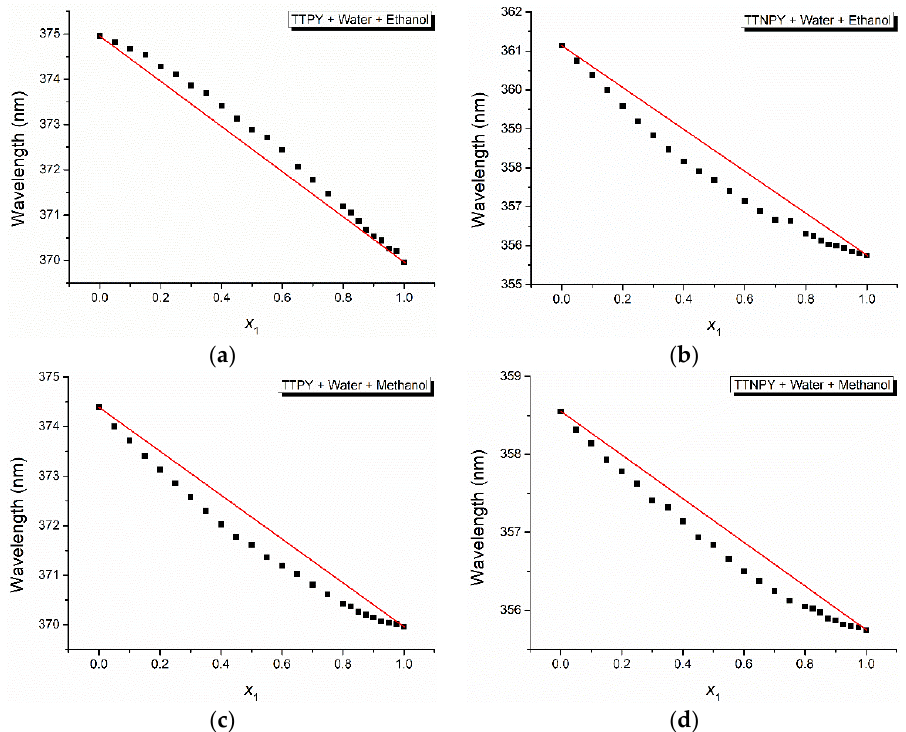
Figure 8. Wavelength in the maximum of the electronic absorption bands versus the water content for the investigated binary solvent mixture solutions of 4-tolyl-1,2,4-triazol-1-ium phenacylid (TTPY) ( a , c ) and 4-tolyl-1,2,4-triazol-1-ium-4 ’ -nitro-phenacylid (TTNPY) ( b , d ).